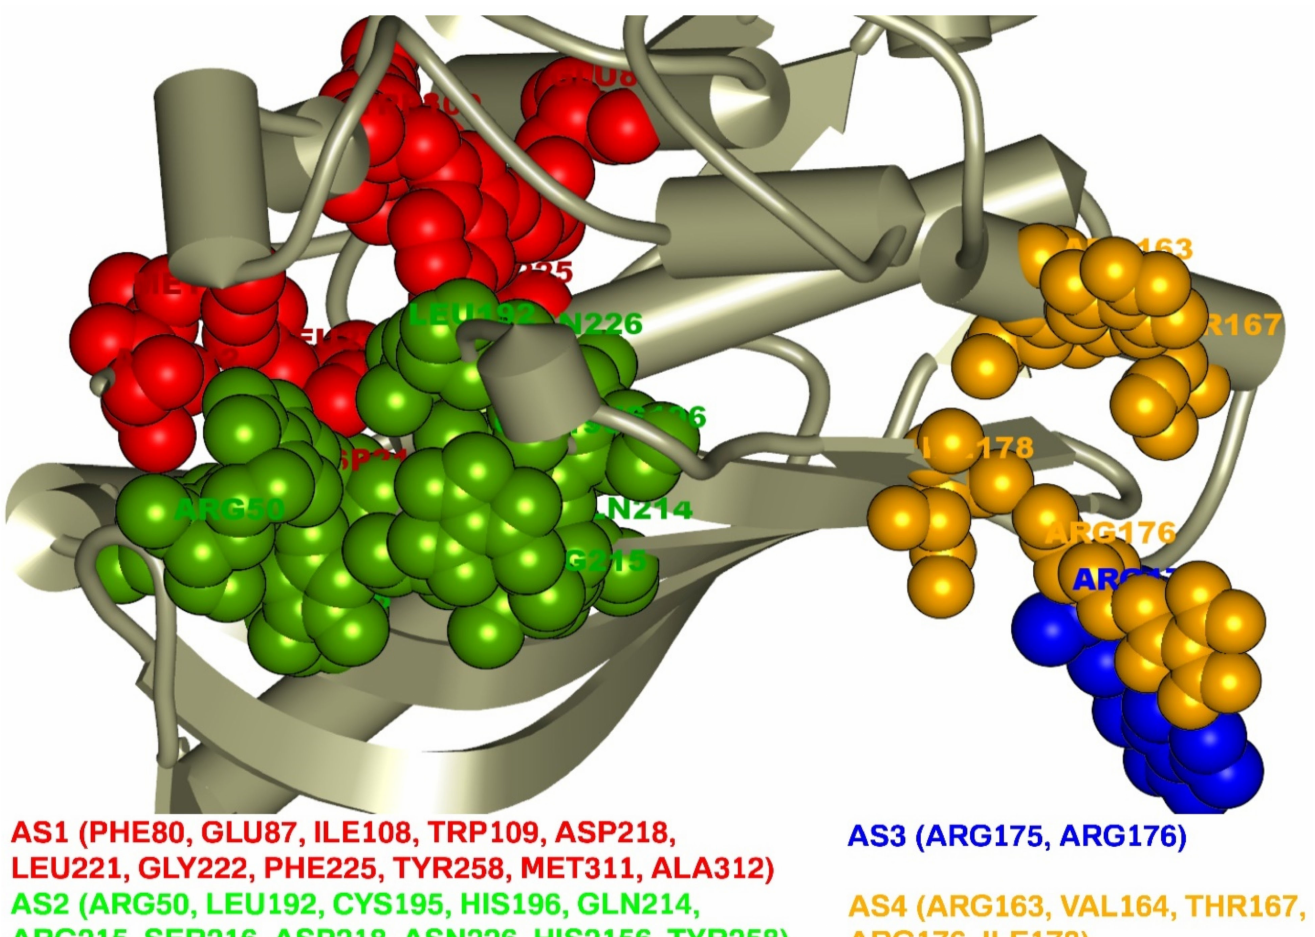
Figure 1. Active site and correspondence binding site of thymidylate synthase. Ball shape with red, green, blue, and yellow representing AS1, AS2, AS3, and AS4, respectively, with their binding site position of the thymidylate